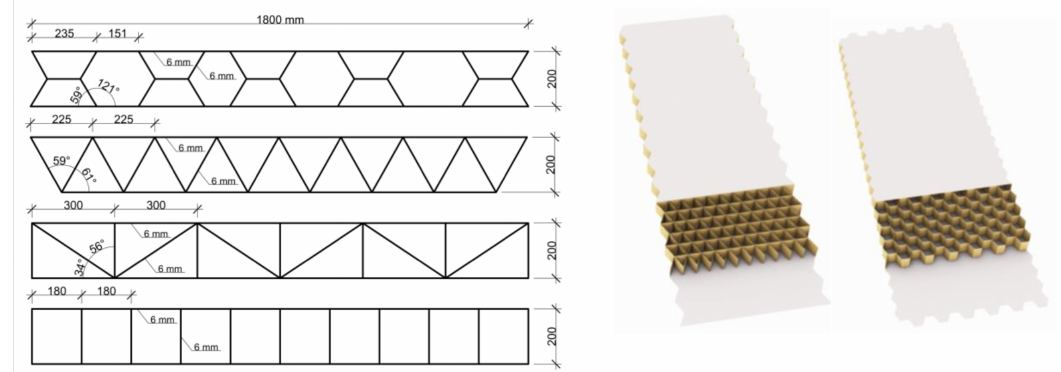
Figure 2. Cross-section of pultruded deck panels in mm ( left ); sandwich panels ( right ).